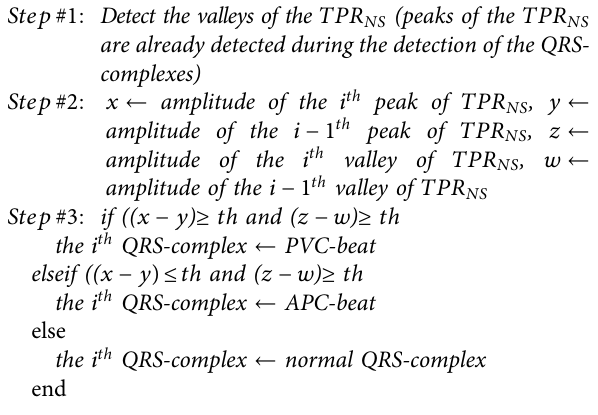
Frontiers in Signal Processing |